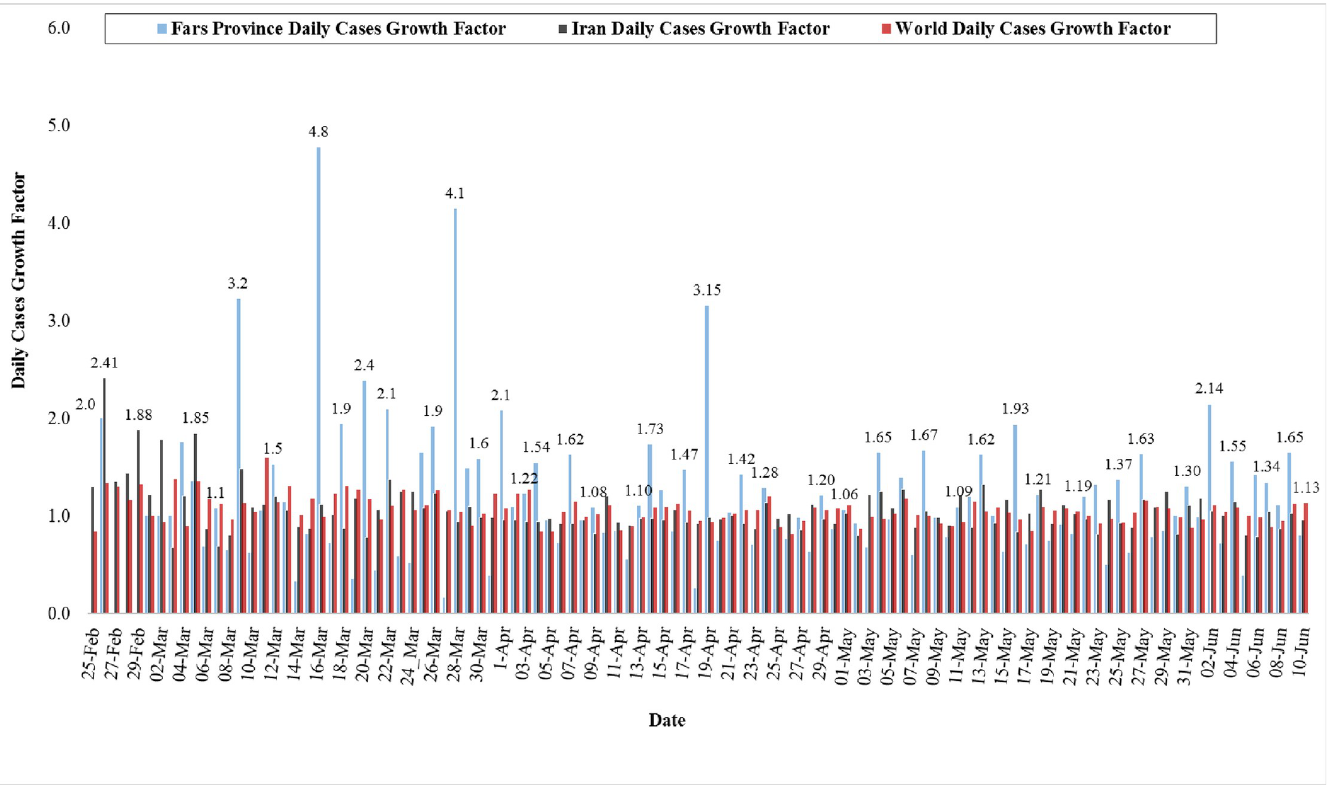
Fig 8. Growth rate of active cases in the world, Iran, and Fars Province (From 25 February to 10 June 2020).